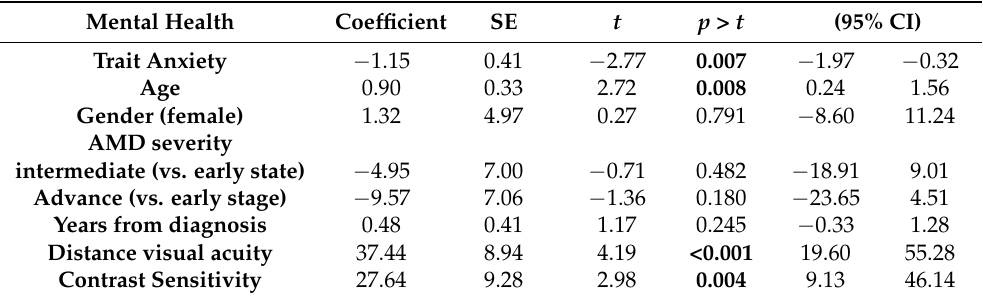
Table 6. Multiple linear regression model that correlates trait anxiety with the subscale Mental Health from the quality-of-life questionnaire NEI-VFQ-25.